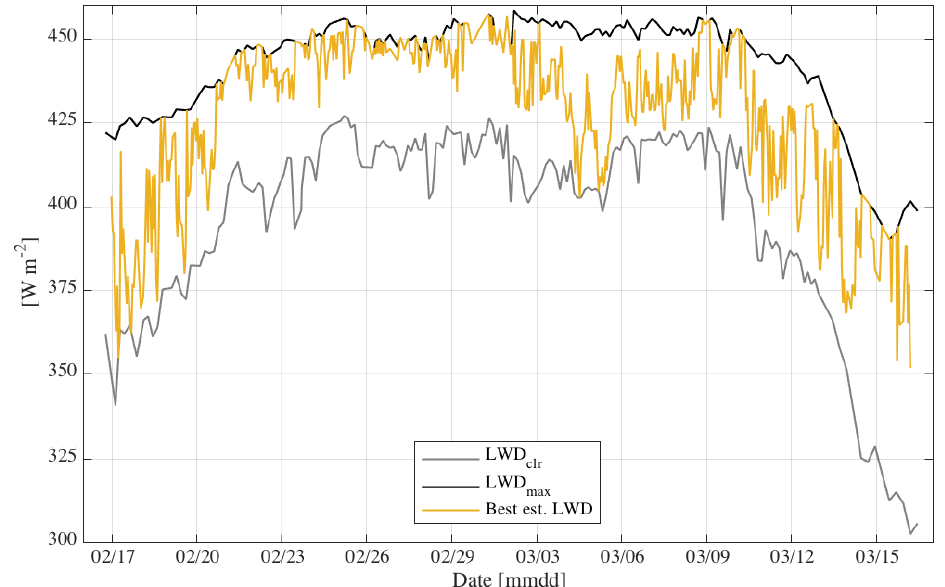
Figure 19. Time series of our best estimate of hourly longwave downwelling radiation (LWD) during the ENRR cruise, compared with hourly estimates during clear-sky conditions, LWD clr , and in the presence of a hypothetical optically thick cloud scaled by the observed cloud area fraction with a base height of 1kma.s.l., LWD max . Table 7. Estimates of the uncertainties in the longwave radiation variables plotted in Fig. 19 and in other variables used to calculate the surface heat budget in Fig. 20. Refer to the text for details of the estimates. The combined uncertainty is the estimated uncertainty in the surface heat budget, Q 0 , as found by combining the individual estimates in quadrature. Variable Source of uncertainty Uncertainty (Wm − 2 )